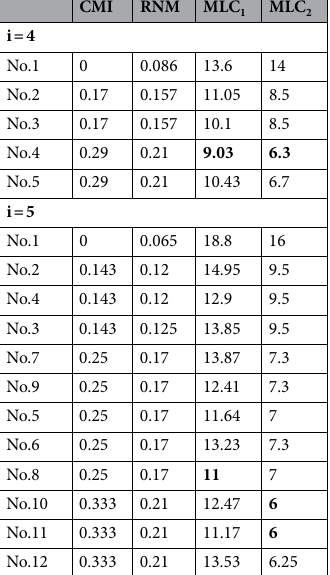
Table 2. An example of mutual relation between CMI, RNM, MLC 1 and MLC 2 indicators for class#4 and class#5. Significant values are in [bold].